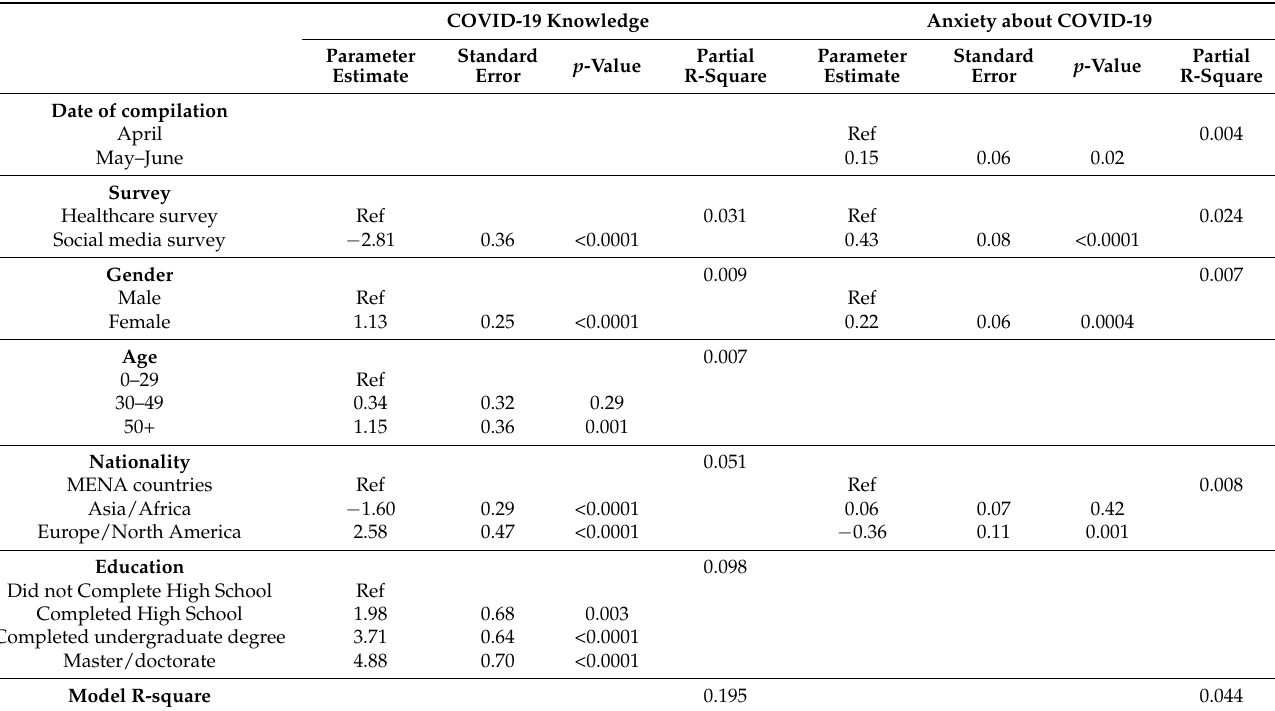
Table 3. Multivariable analysis of demographic factors associated with knowledge and anxiety.